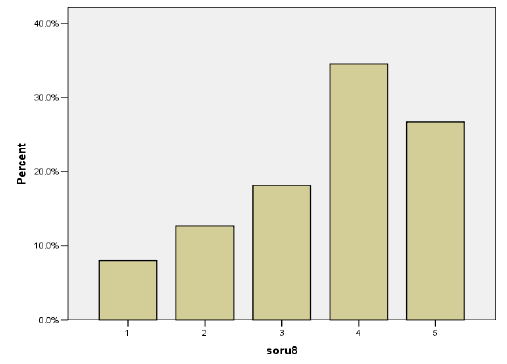
Figure 8. Is it advantageous for university students to gather a deep knowledge of TAS and Turkish auditing standards?